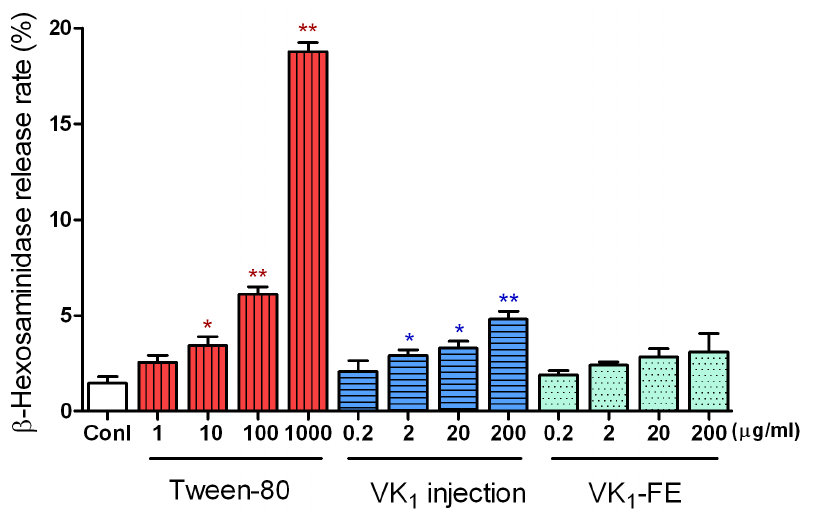
Figure 2. Effect of vitamin K 1 (VK 1 ) injection on b -hexosaminidase release in RBL-2H3 cells. RBL-2H3 cells were treated with the different drugs for 30 min. The supernatants were collected, and the absorbance was measured at 405 nm. The supernatant from cells stimulated with Triton was considered to represent the total b -hexosaminidase release. The b -hexosaminidase release rates are shown as the mean 6 SE, n=6. * P , 0.05, ** P , 0.01 vs. control (conl). VK 1 -FE: vitamin K 1 -fat